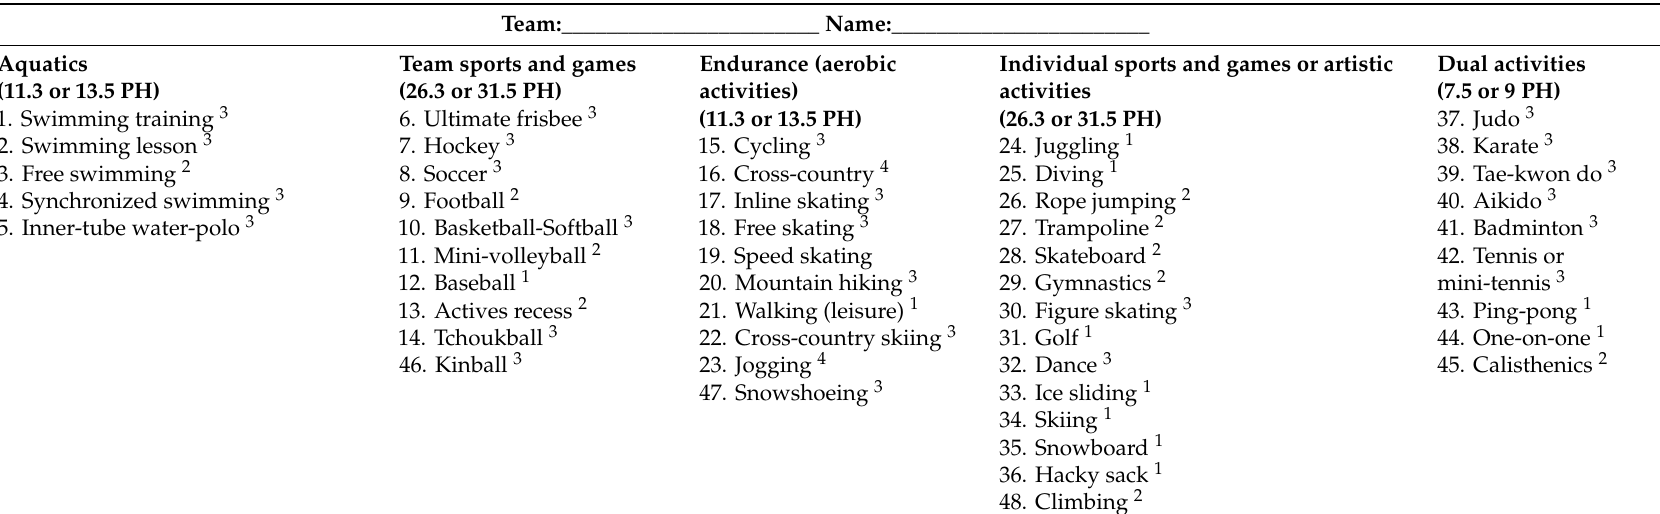
Table A2. Personal Physical Activity Practice Declaration Sheet / Self-report